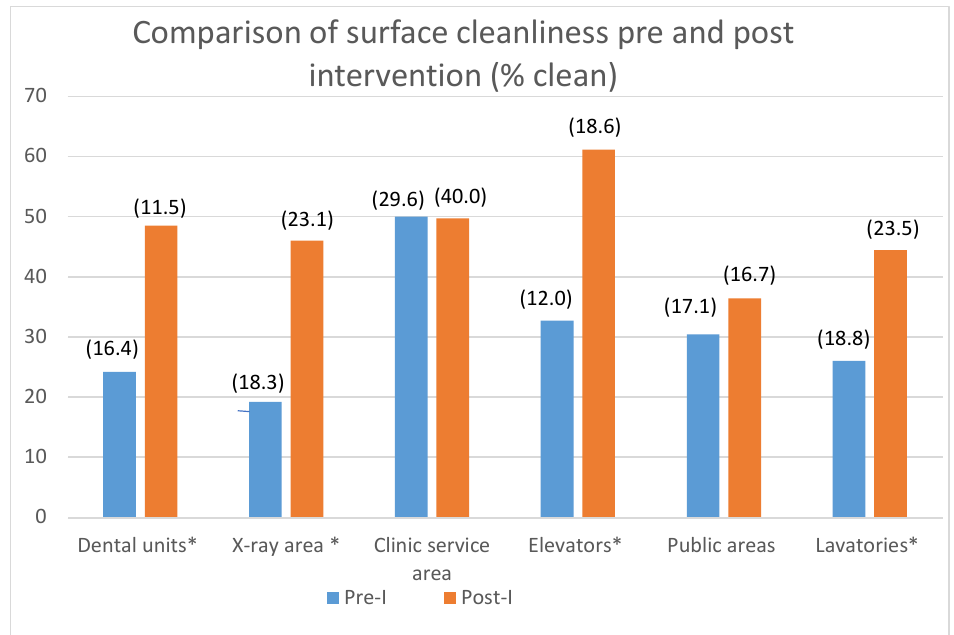
Figure 5. Comparison of surface cleanliness pre- and post-intervention (% clean). * Surfaces in which significant differences were found between pre-I and post-I; numbers in parenthesis represent the standard deviation (SD) values for each bar.